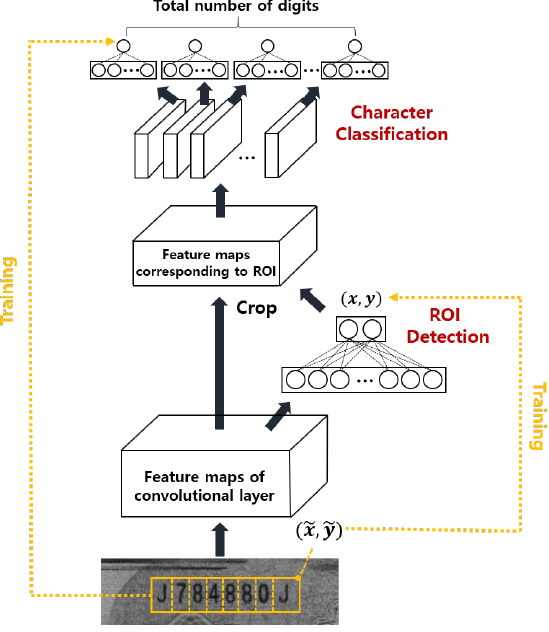
Figure 6. The joint ROI detection and classification